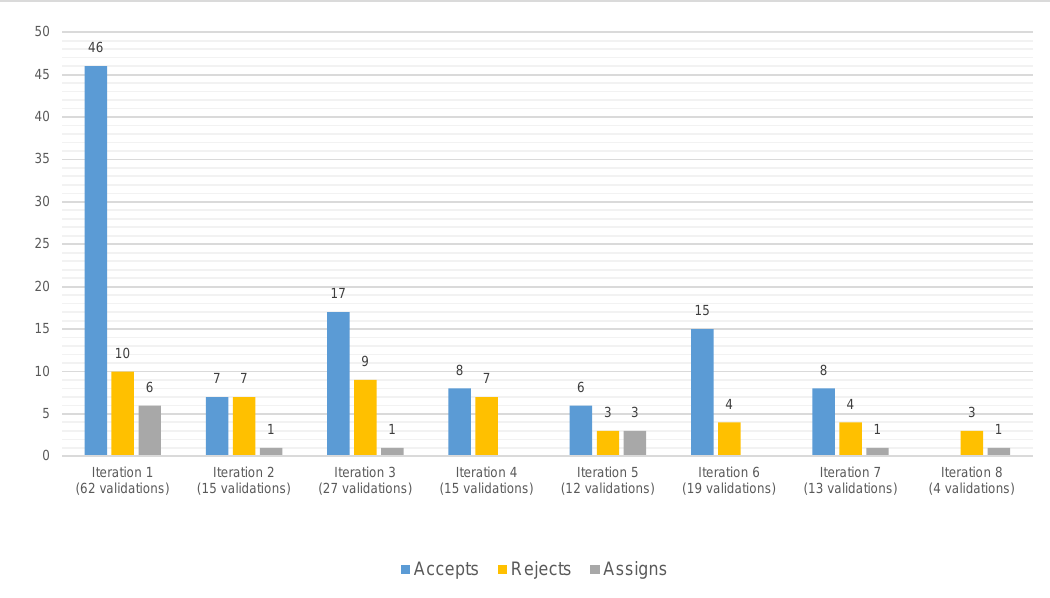
Figure 4. Number of rooms accepted, rejected, and assigned per iteration.